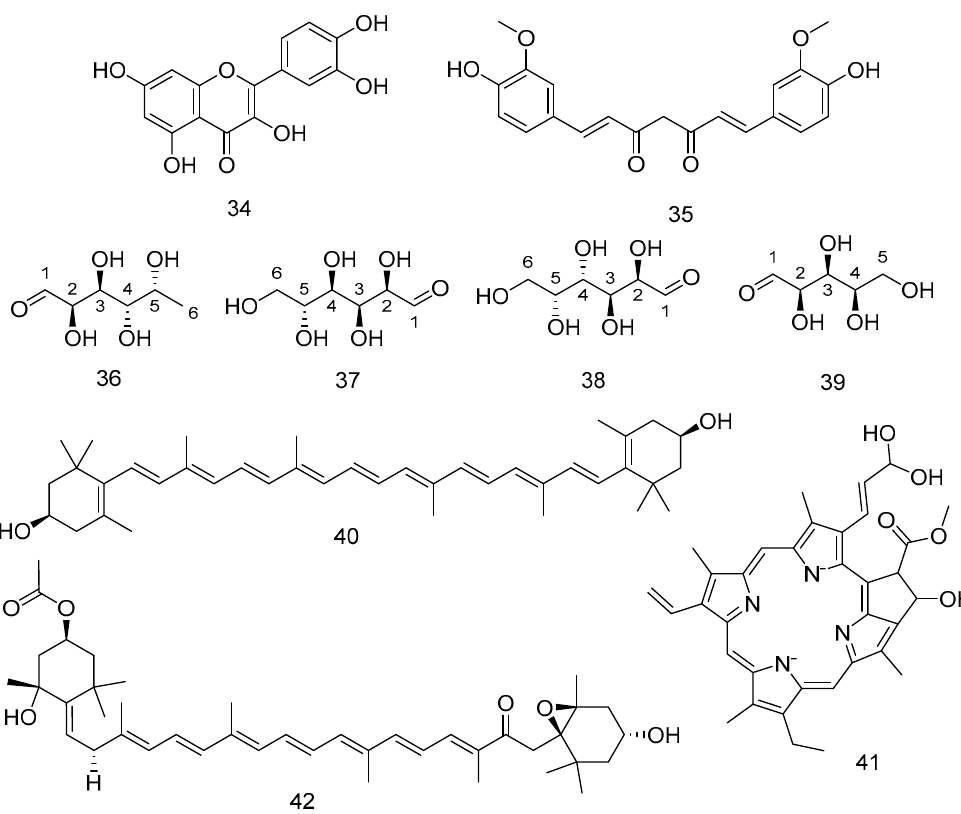
Figure 10. Compounds from 34 – 42 (Carotenoids, flavonoids, sugars, and carotene). Some of the phytochemicals detected in the rock seaweeds are phlorotannins. Phlorotan- nins are polymers, complex in nature and formed of several monomers named phloroglucinol 43 [192,221]. It showed also antithrombotic and profibrinolytic effects [194]. The aqueous ethanolic and aqueous extract from F. spiralis , A. nodosum , and P. can- aliculata were analysed by UPLC-MS. F. spiralis showed the lower molecular weight phlo- rotannins of less than six monomers, while the other two showed higher molecular weight phlorotannins [222]. Other compounds from F. spiralis are 7-methoxycoumarin 44 [223],